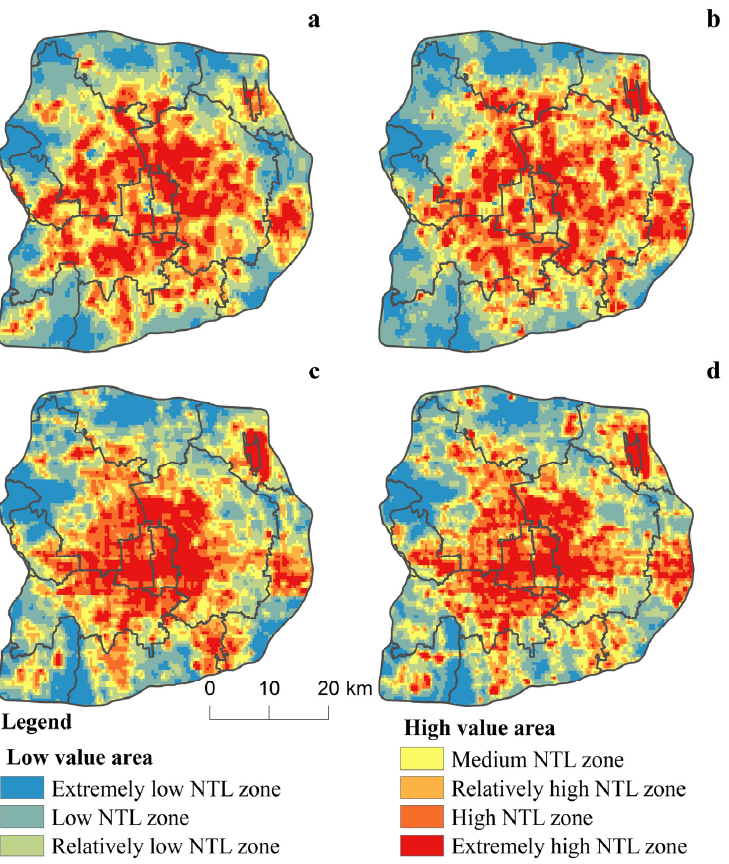
Figure 3. Spatial distribution of NTL within the sixth ring road of Beijing in: ( a ) 2004, ( b ) 2009, ( c ) 2014, ( d ) 2019. Table 3. Proportions of areas with high and low NTL values in each administrative region within the sixth ring road of Beijing from 2004 to 2019.